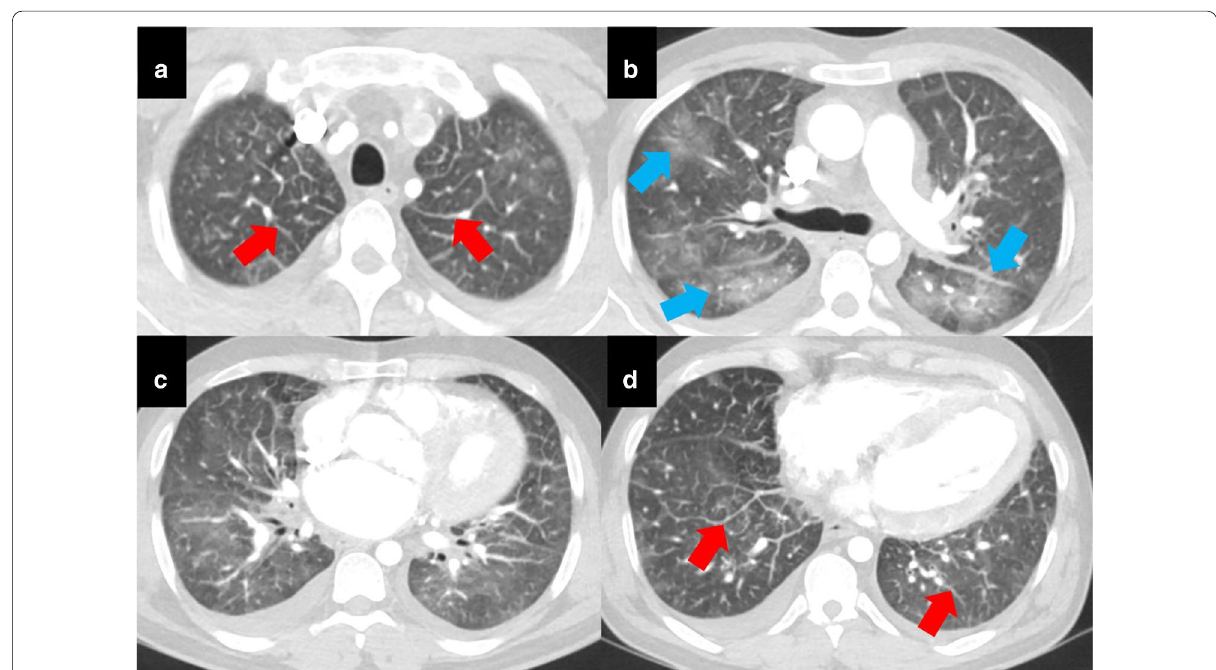
Fig. 16 Availability and regret bias causing faulty reasoning error. A 41-year-old male patient with aortic valve stenosis was admitted to the Emergency Department with epigastric pain during the COVID-19 pandemic. A thoracoabdominal CT was ordered to assess the aortic stenosis, lung parenchyma and possible causes of epigastric pain. The on-call radiologist on the night-shift correctly described the CT findings as cardiomegaly, bilateral ground-glass opacities predominantly in the upper lobes of the lungs (blue arrows, b ), thickening of the interlobular septae (red arrows, a , d ) and bilateral pleural effusion. Before the CT of this patient, the radiologist had reported a large number of CTs compatible with viral pneumonia during the night-shift. In addition, he had overlooked a patient with positive chest CT finding for COVID-19 pneumonia on